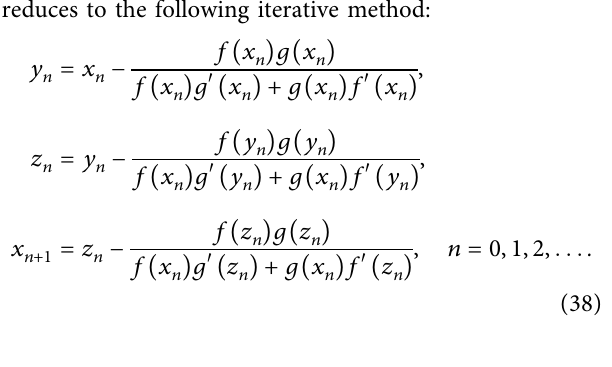
Algorithm 10. Taking p � 1 , w